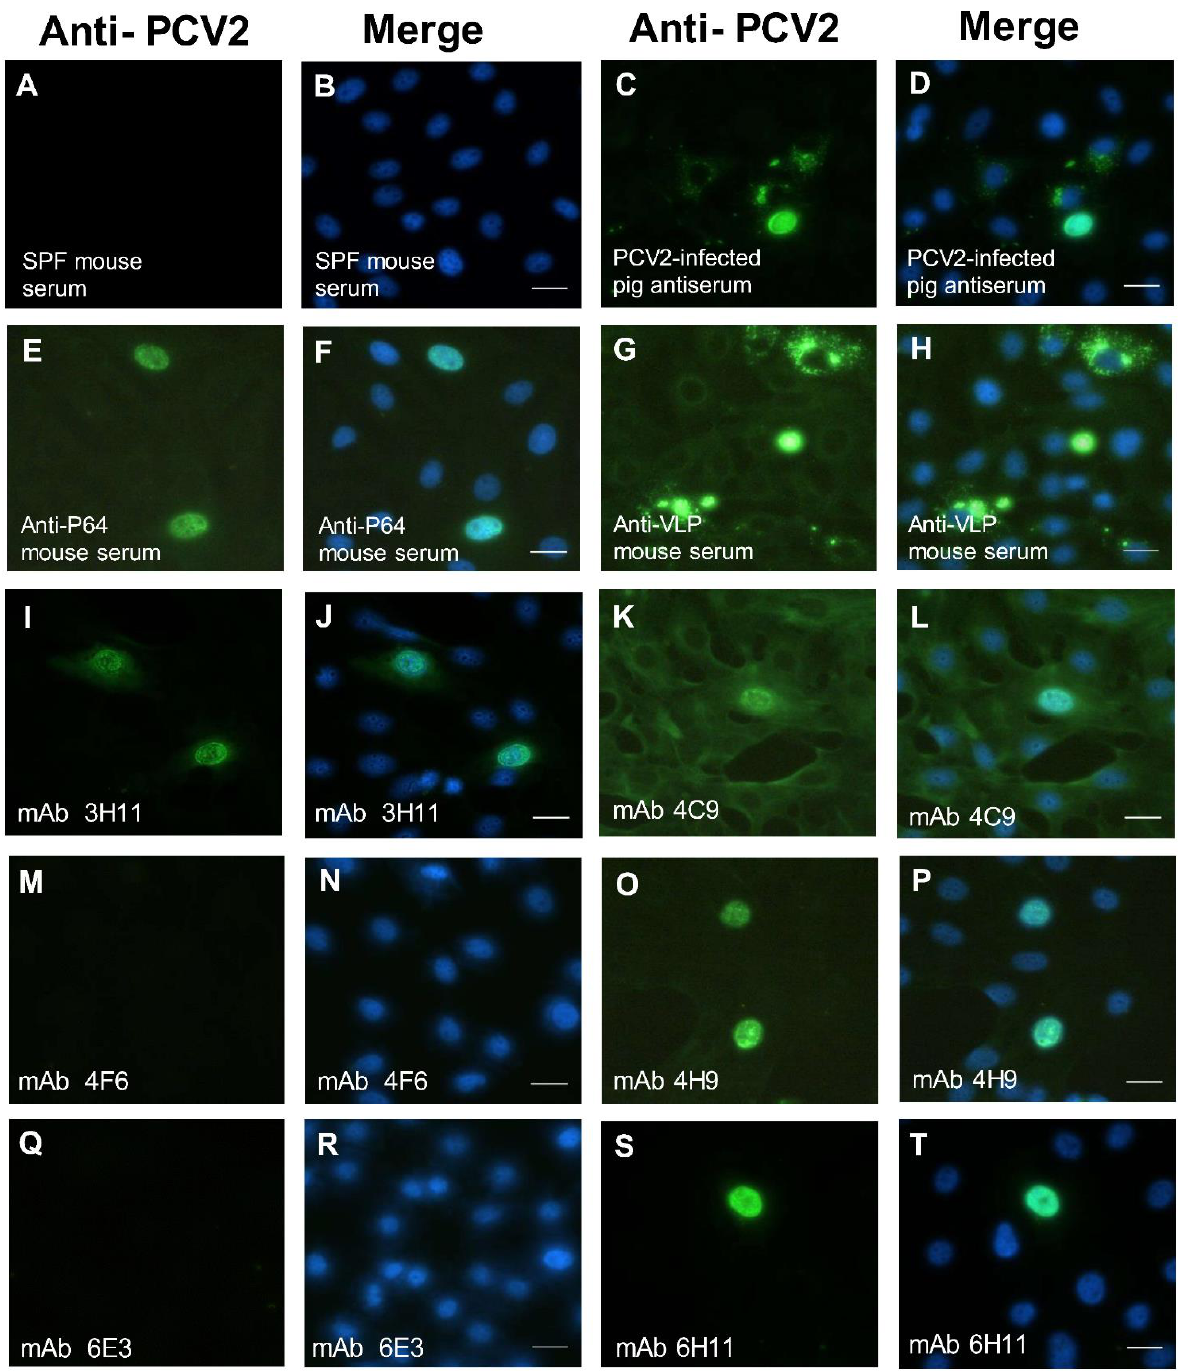
Figure 2. The localization of viral proteins of PCV2 on PCV2 (strain: T657)-infected porcine kidney cells. The localization of viral proteins of PCV2 was assessed by indirect immunofluorescence assay (IFA) using anti-PCV2 polyclonal antisera ( C – H ) and anti-P64 mAbs ( I – T ) on the Porcine Circovirus Type 2 FA substrate slide (VMRD). Staining with SPF mouse serum was used as the negative control ( A , B ). Staining with PCV2-infected pig antiserum ( C , D ), anti-P64 mouse serum ( E , F ), and anti-VLP mouse serum ( G , H ) were used as positive controls and to identify all viral proteins of PCV2 ( C , D ), C-terminus of the capsid protein of PCV2a ( E , F ), and VLP of PCV2a ( G , H ), respectively. Left column ( A , C , E , G , I , K , M , O , Q , S ): Fluorescence microscopy of viral proteins of PCV2 was identified (green). Right column ( B , D , F , H , J , L , N , P , R , T ): Nuclei were stained with DAPI (blue) and the merge of the images was shown. The scale bar is 20 μm.